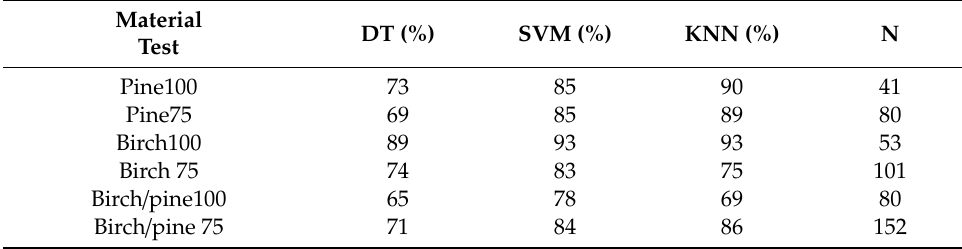
Table 3. Classification results, correct classification (%). Classification of heartwood content from pine chips, bark content from birch chips and pine chips from birch chips and birch bark. MC range 0–60%. Test groups and correct classification using decision tree (DT), support vector machine (SVM) and K-nearest neighbor (KNN). N = number of samples. Birch / pine classification included three classes: birch, pine and birch bark.